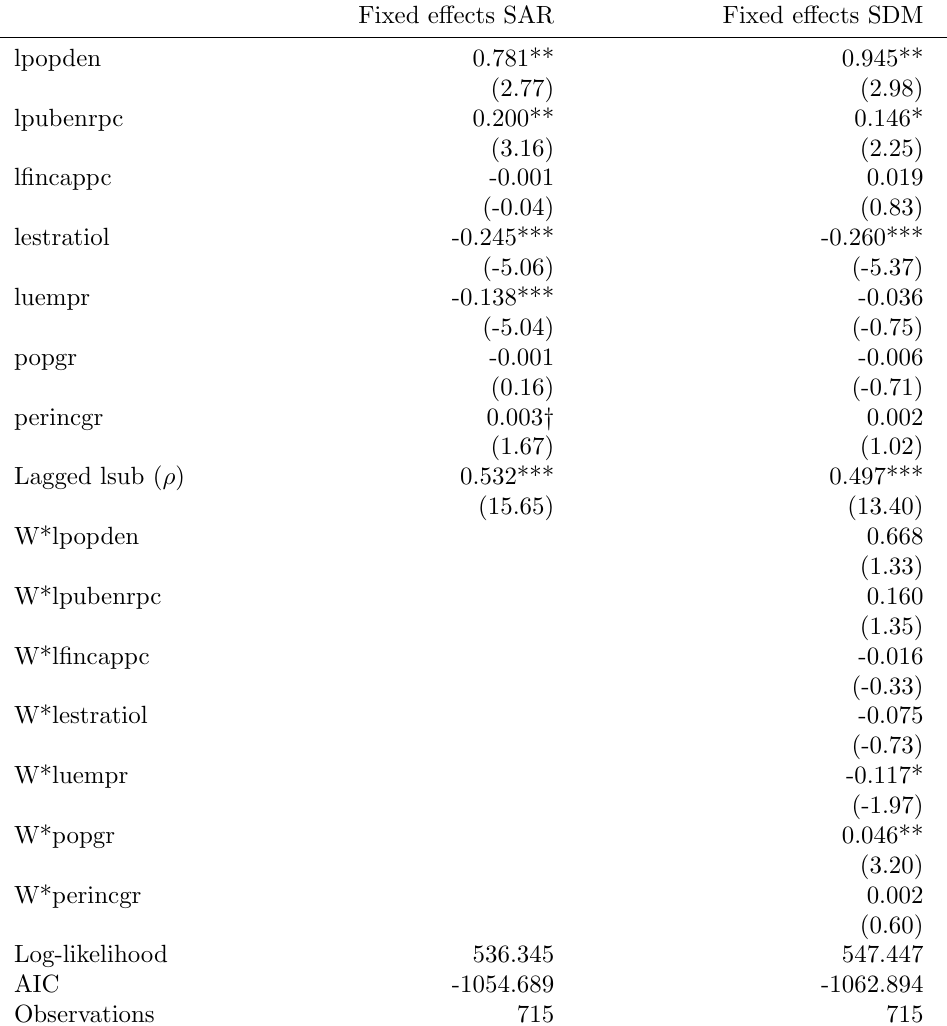
Table 4: Spatial panel models Fixed effects